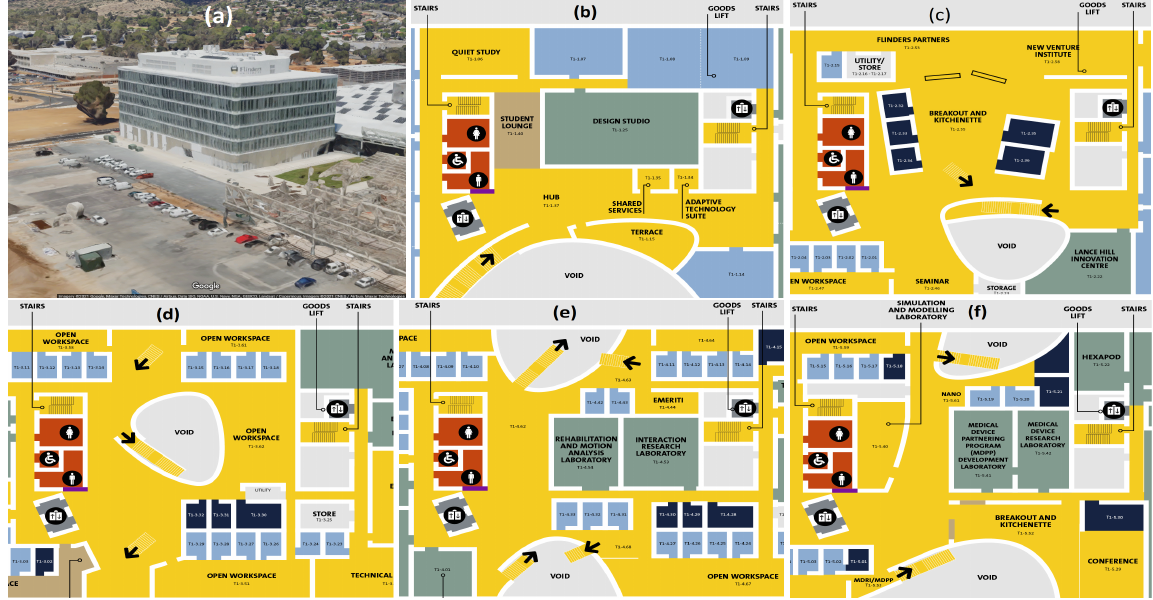
Figure 2: (a) Tonsley building view from the north-side parking lot, (b)-(f) Tonsley Building layout of levels